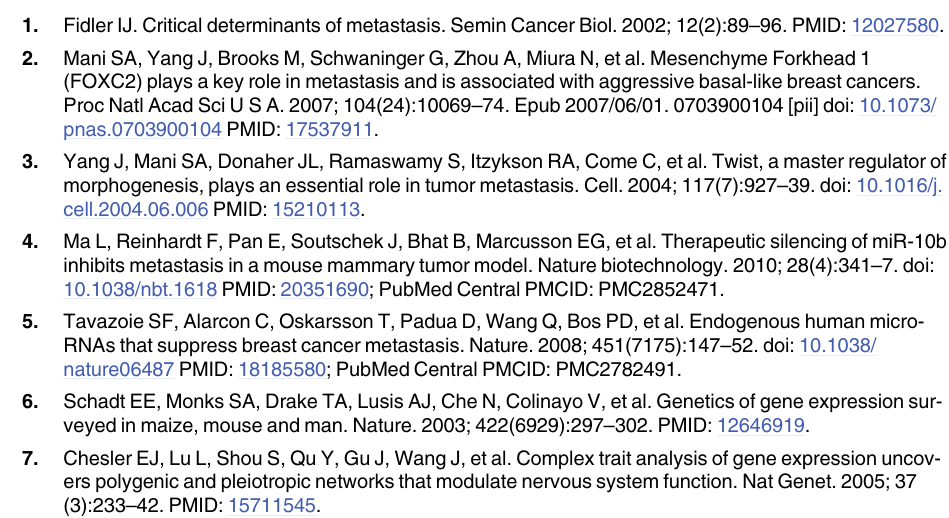
S2 Table. Genes with negative expression correlations with Cnot7 whose mRNAs are asso- ciated with the CNOT7 protein. S3 Table. Human-mouse gene symbol matching for GOBO weighted gene signature prog- nosis analysis. S4 Table. Genes with negatively correlated with Cnot7 expression that contain the CPE/ CPSF/NRE tripartite RNA binding protein motif. S5 Table. Ingenuity Pathway Analysis of CPE/CPSF/NRE bearing, Cnot7 negatively corre- lated genes. S6 Table. Primers and primer sequences used in this